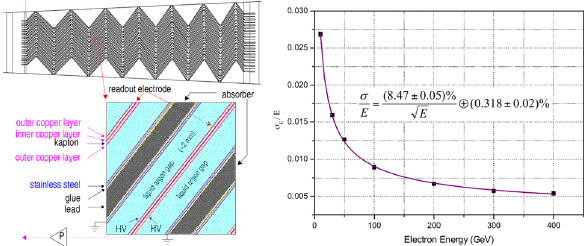
Fig. 8 Longitudinal view of one cell of the ATLAS LAr Calorimeter, showingtheaccordionstructure(left).TheLHeCLArenergyresolution forelectronsbetween10and400GeVassimulatedusingGEANT4[73] (right)